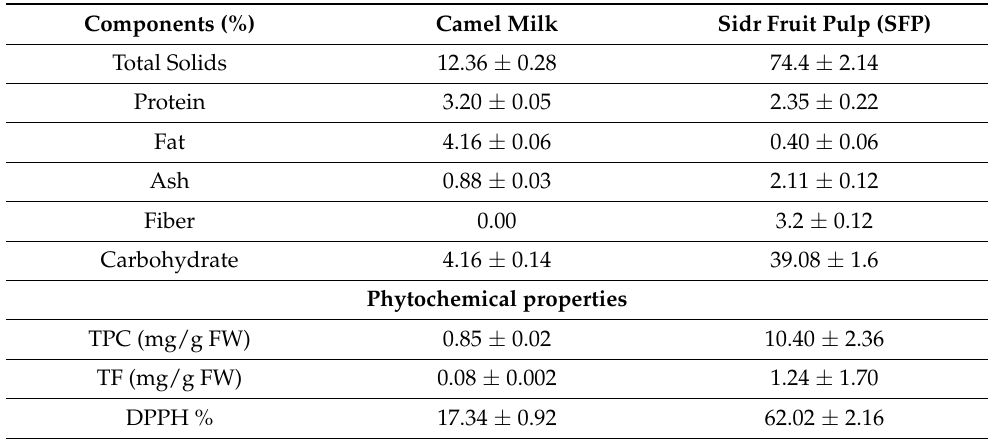
Table 1. Chemical composition and phytochemical properties of camel milk and sidr fruit pulp